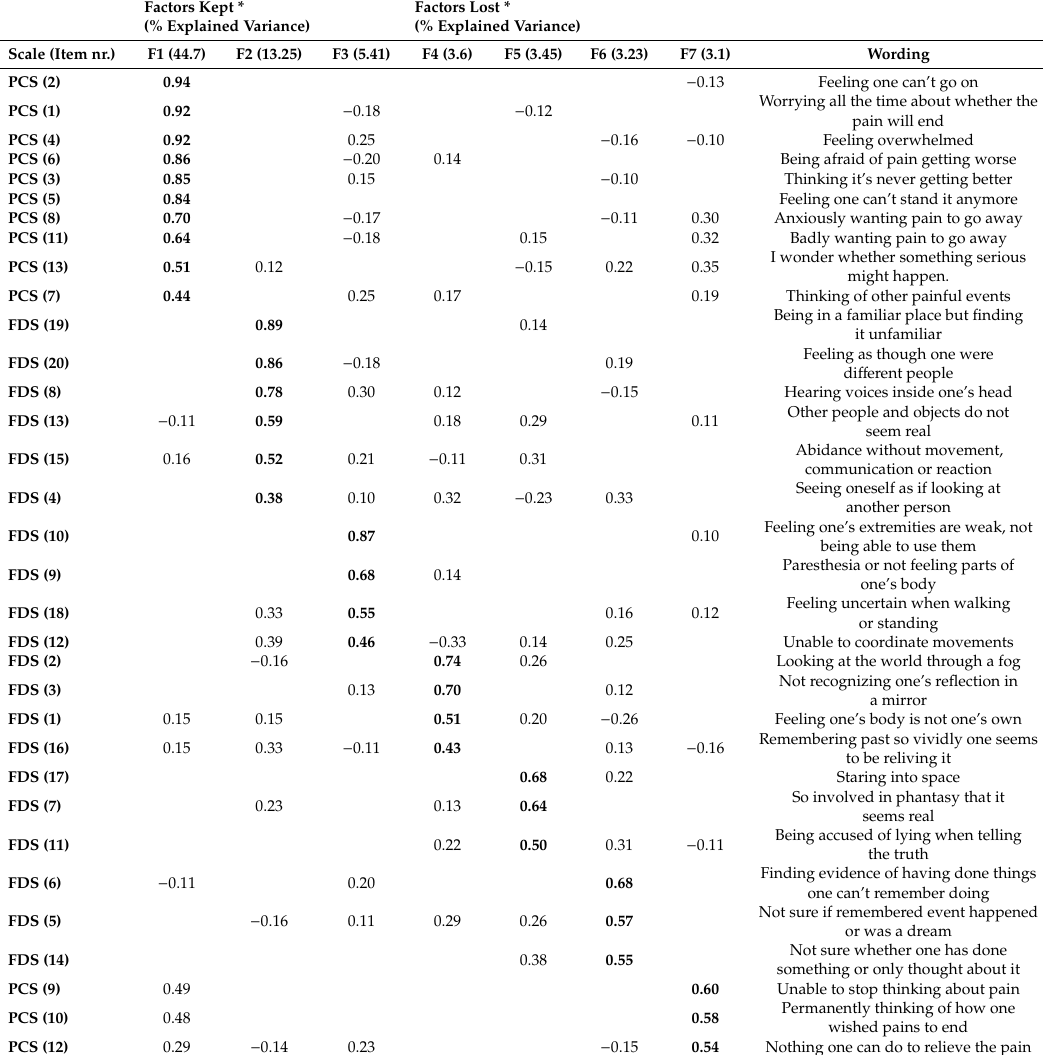
Table 3. Latent factors (F1-F7) of the PCS and the FDS-20, respectively, along with the respective factor loadings and wordings of the items. * The number of factors determined to be kept by parallel analysis was 3. Items with the highest loadings on a factor represent that factor (bold face). Factors Kept * (% Explained